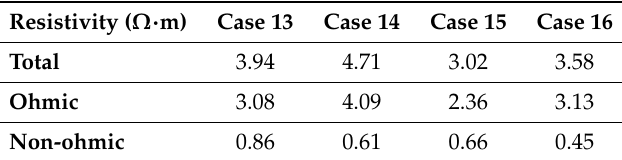
Table 9. The contribution of ohmic and non-ohmic resistance for Cases 13, 14, 15, and 16 of Table 5 (i.e., with cylindrical